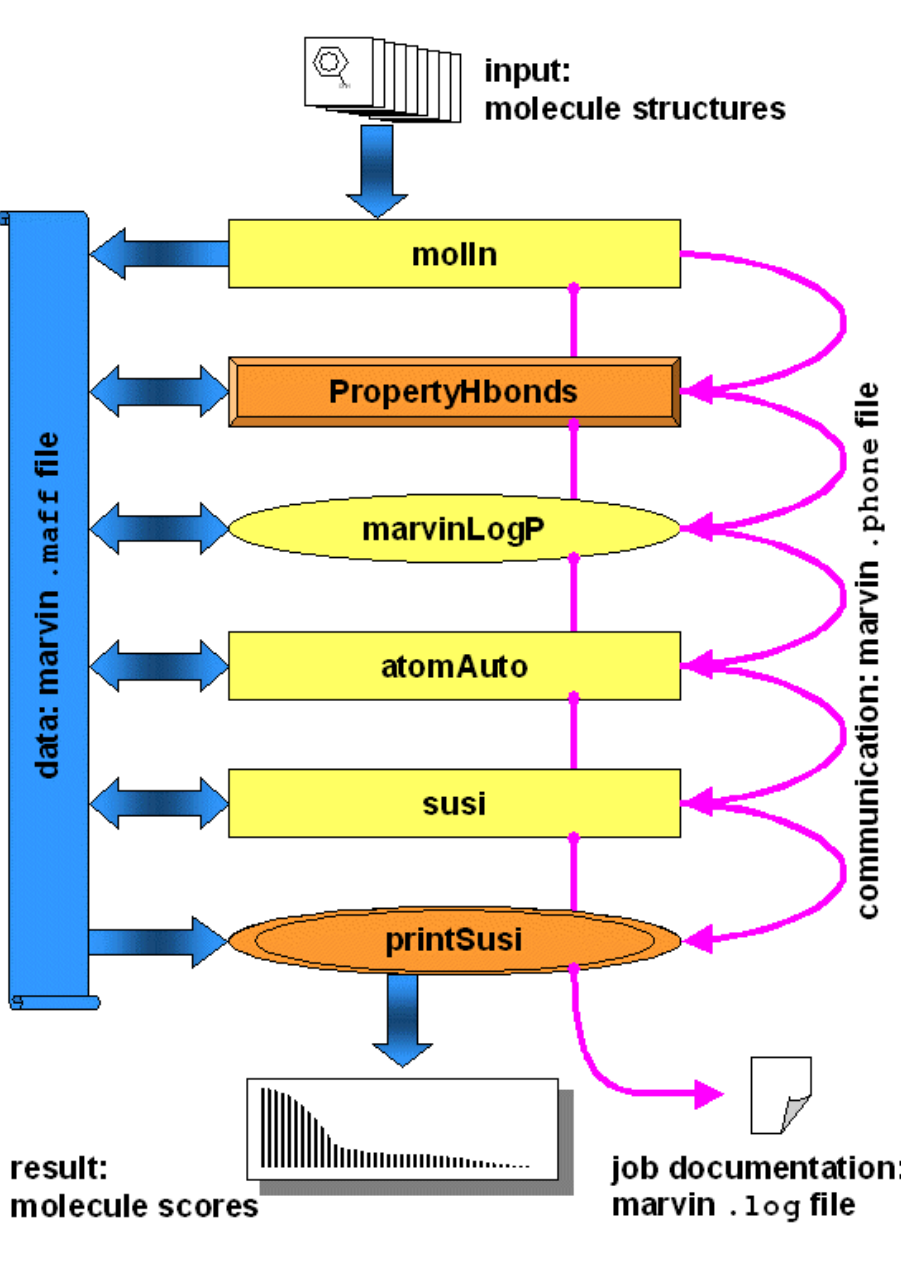
Figure 2: Visualization of the modular structure of a marvin algorithm (see Section 4 for the example study). Data sets are transferred between applications by so-called maff data files. Different types of applications, such as generic applications (displayed as yellow rectangles), interfaced applications (ovals) or high-level applications (in orange and 3D representation) are used seamlessly in order to include all functionality needed by the marvin algorithm. Blue arrows indicate data flow, magenta arrows indicate control